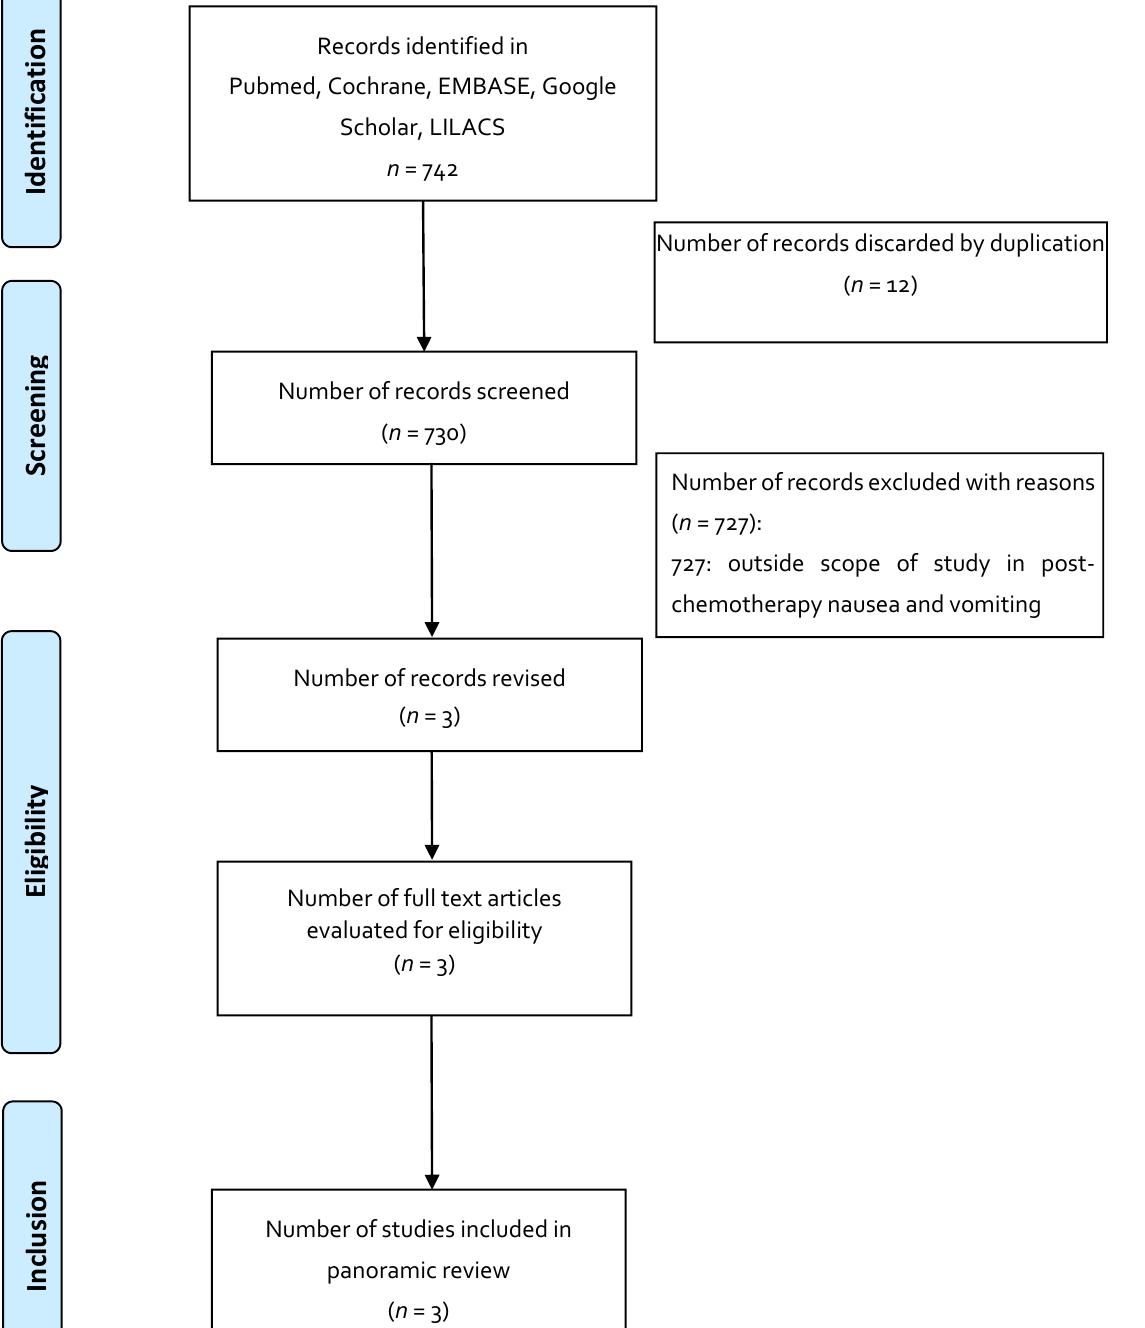
Figure 2. Flowchart depicting the selection process for the studies included in the paper: indication in nausea and vomiting after chemotherapy.